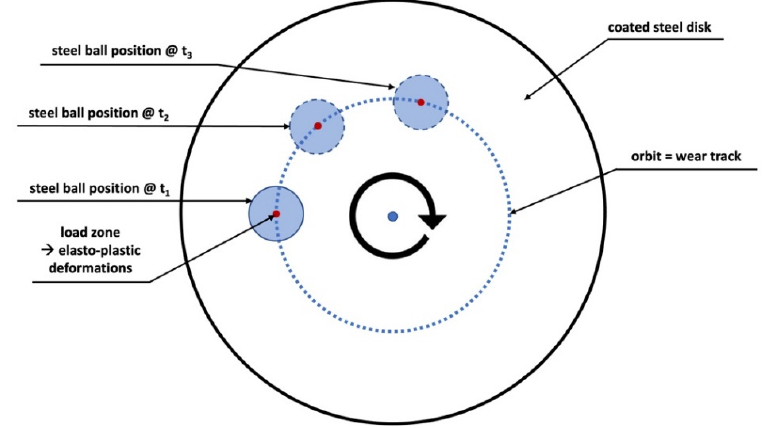
Figure 18. Orbit movement of the ball on the coated test specimen.